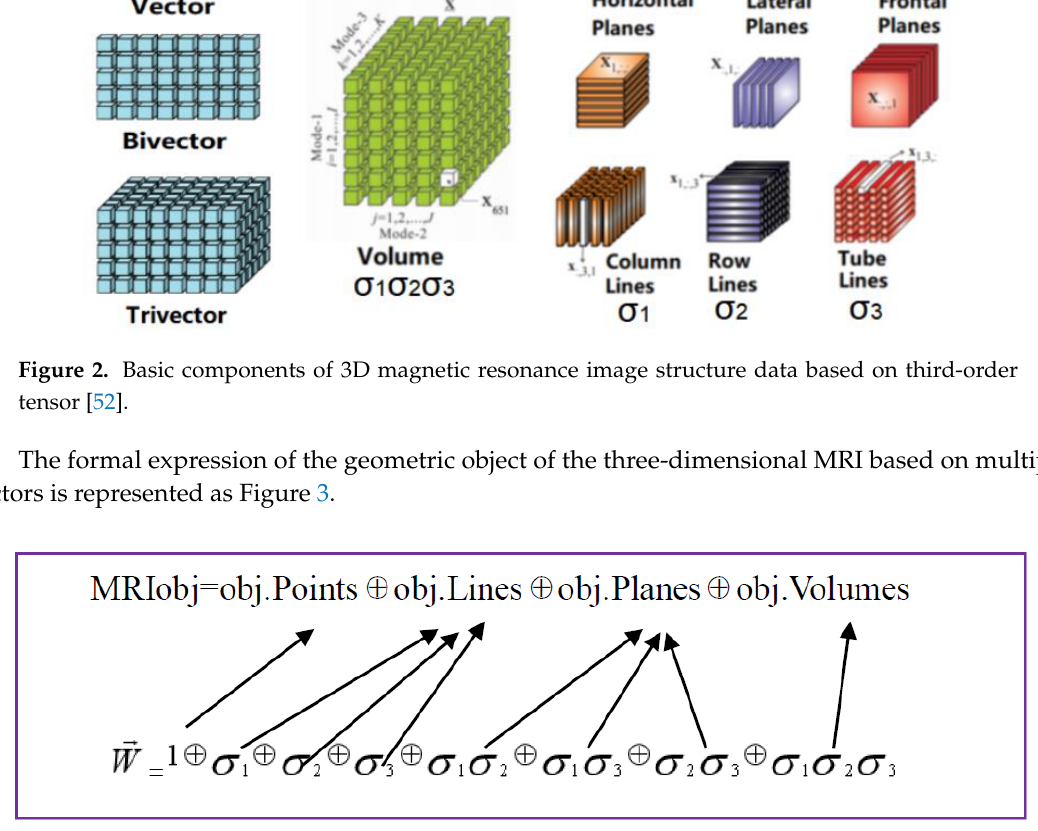
Figure 3. Illustration of the formal expression of the geometric object of the three-dimensional MRI based on multiple vectors is represented.